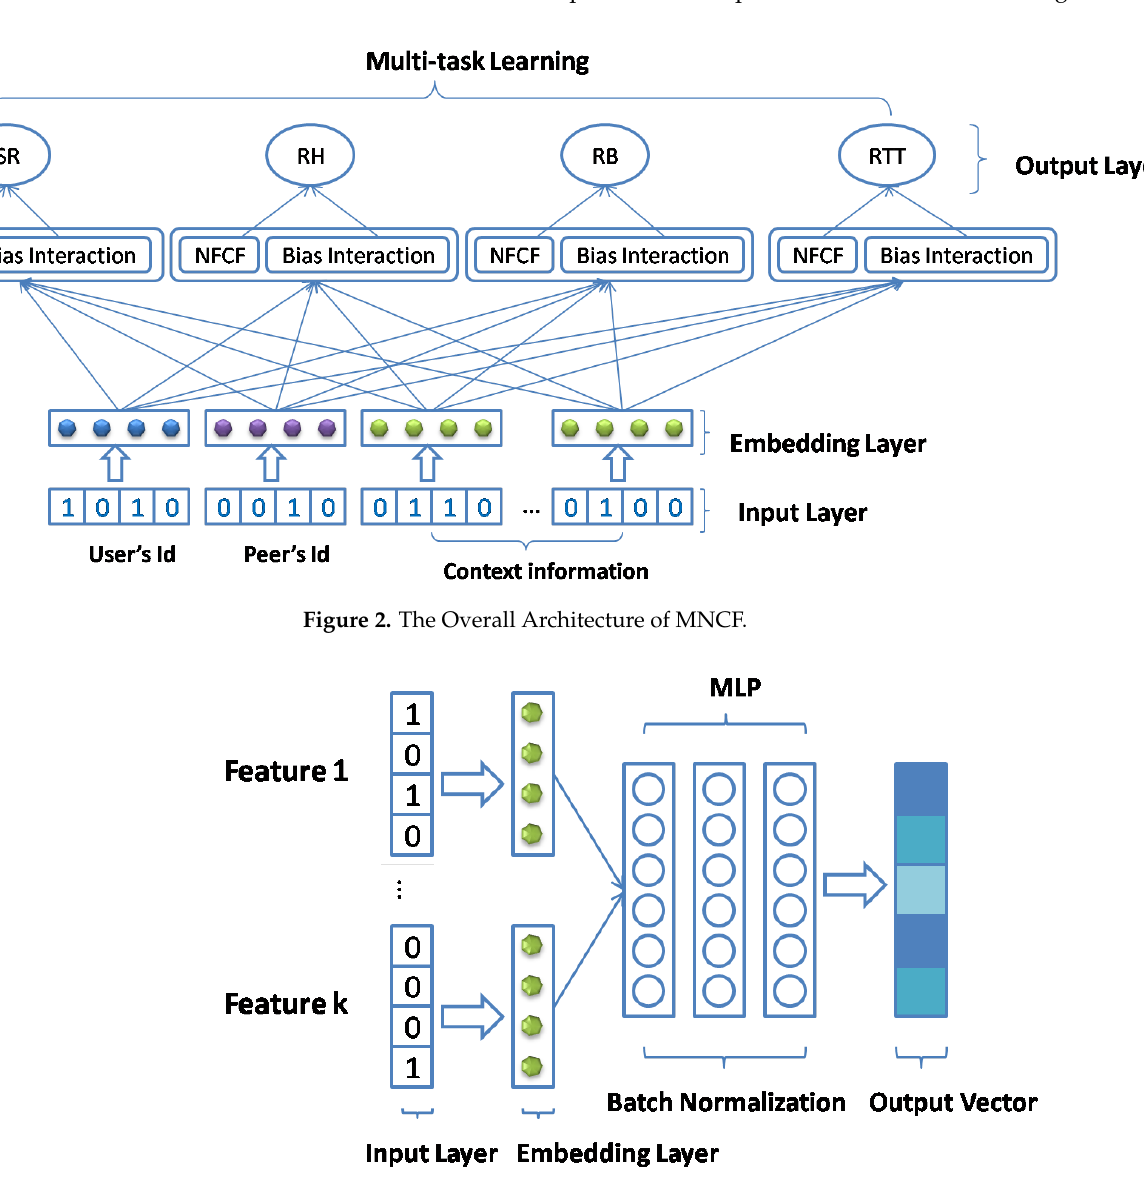
Figure 3. The Context Encoder